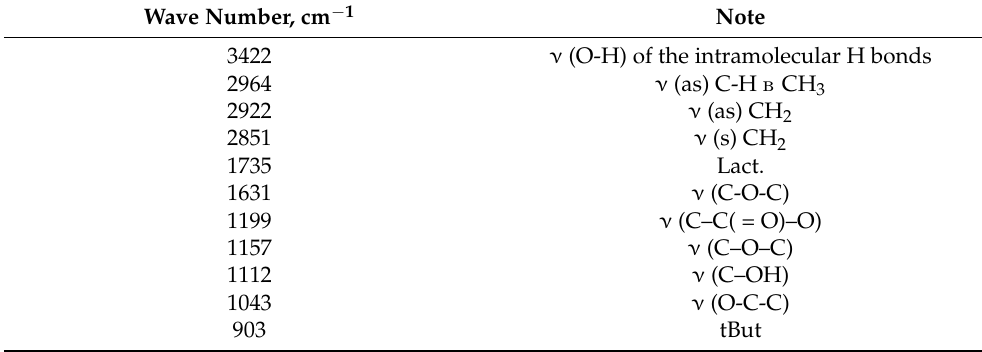
Table 4. IR characteristics of ginkgolide A.